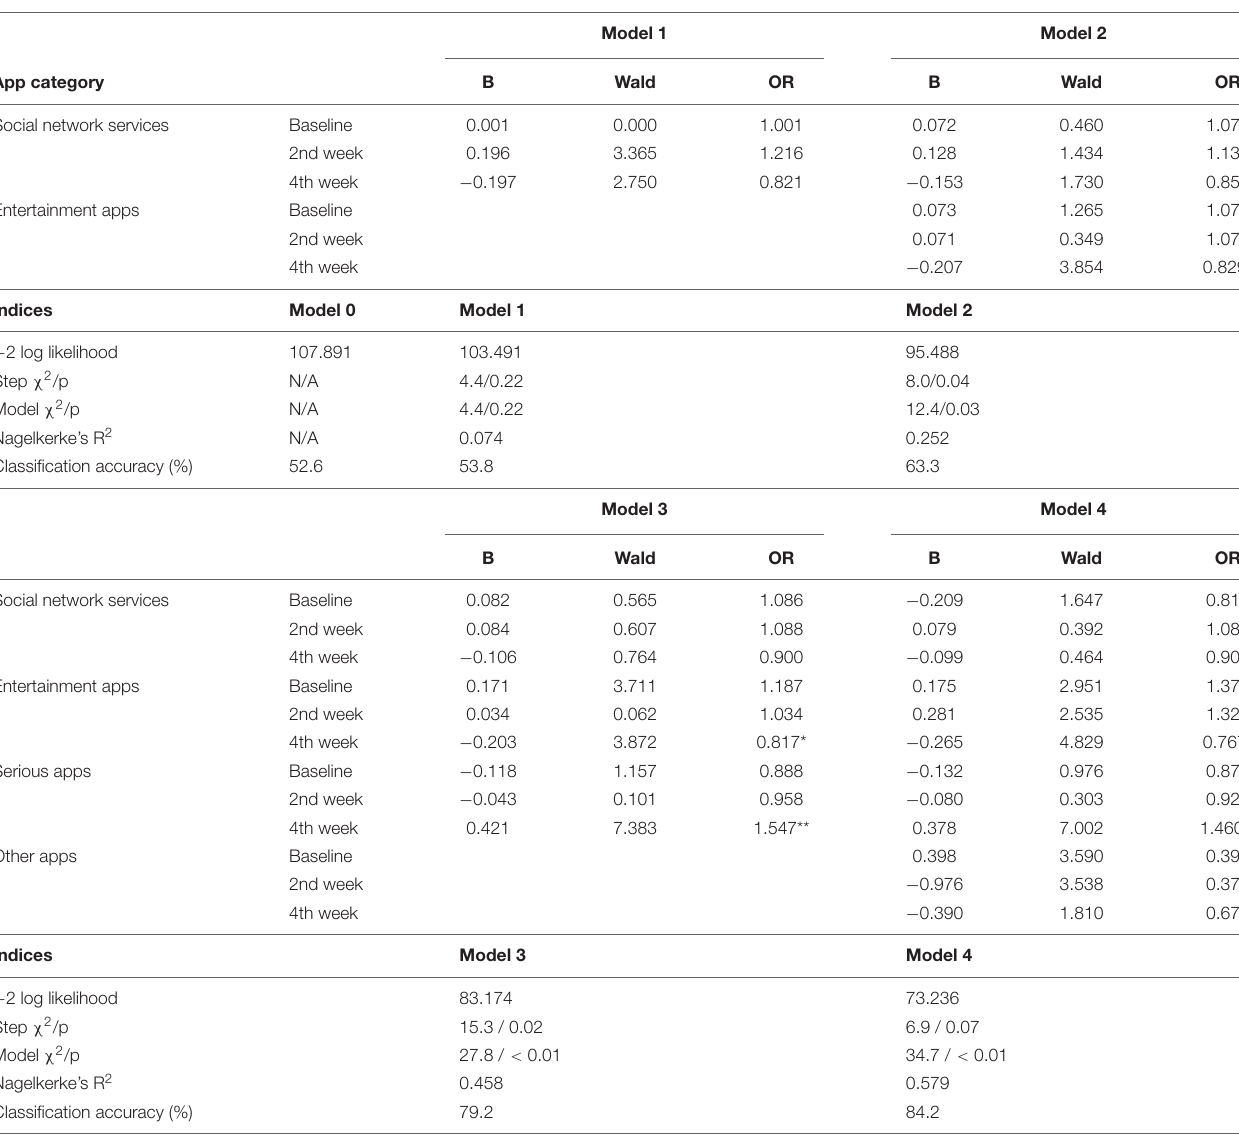
TABLE 2 | Hierarchical logistic regression analysis of the four